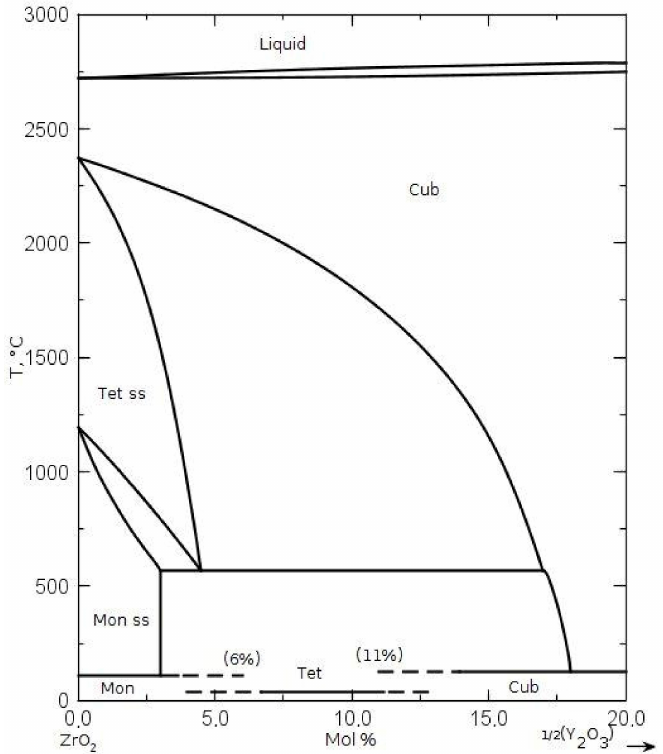
Figure 1. Phase diagram of the ZrO 2 -Y 2 O 3 system [11].